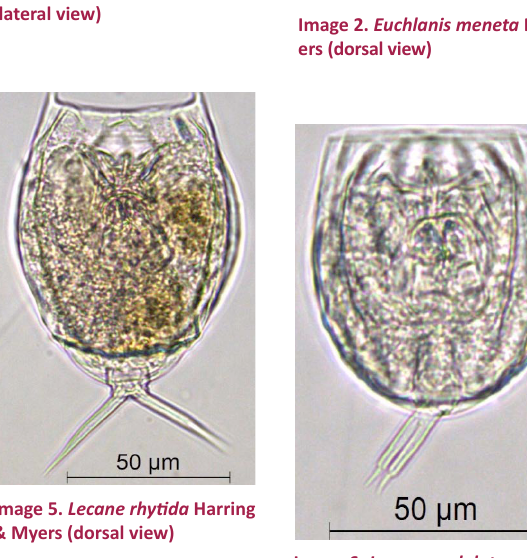
Image 6. Lecane undulata Hauer (dorsal view)